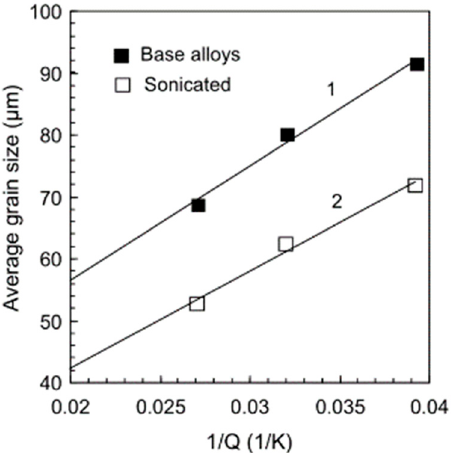
Figure 13. Grain size vs. 1/Q for Mg-3Zn-Zr alloys [88]. “Sonicated” = UST; addition of Zr = 0.5, 10.0 and 1.5, respectively. Reprinted with permission from ref. [88]. Copyright 2008 Elsevier.